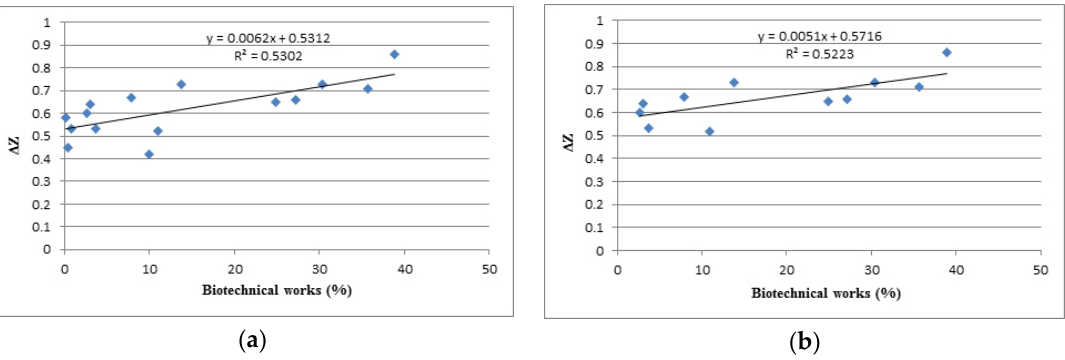
Figure 6. Pearson’s correlation coefficient between the soil erosion intensity (erosion coefficient) and the erosion control works performed for: ( a ) all 15 watersheds; ( b ) for the watersheds with the area smaller than 20 km 2.